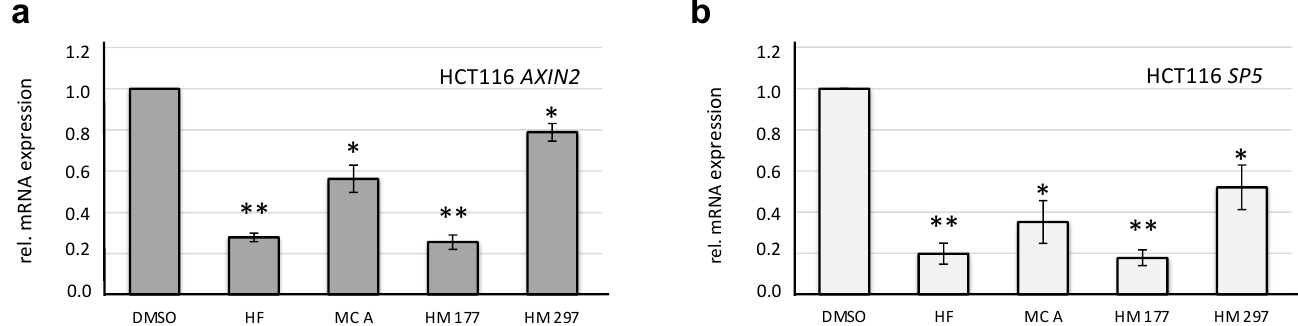
Figure 7. HF and MCs down-regulate mRNA expression of the Wnt target genes Axin2 ( a ) and Sp5 ( b ) in HCT116 cells. Compounds were added at a concentration of 3 μ M for 20 h before total RNA was isolated and used for qRT-PCR. GAPDH was used as a housekeeping gene for normalization to the vehicle (0.1% ( v / v ) DMSO) control. The graph presents the results of 3 independent experiments, each measured in duplicate. * p < 0.05; ** p < 0.01.